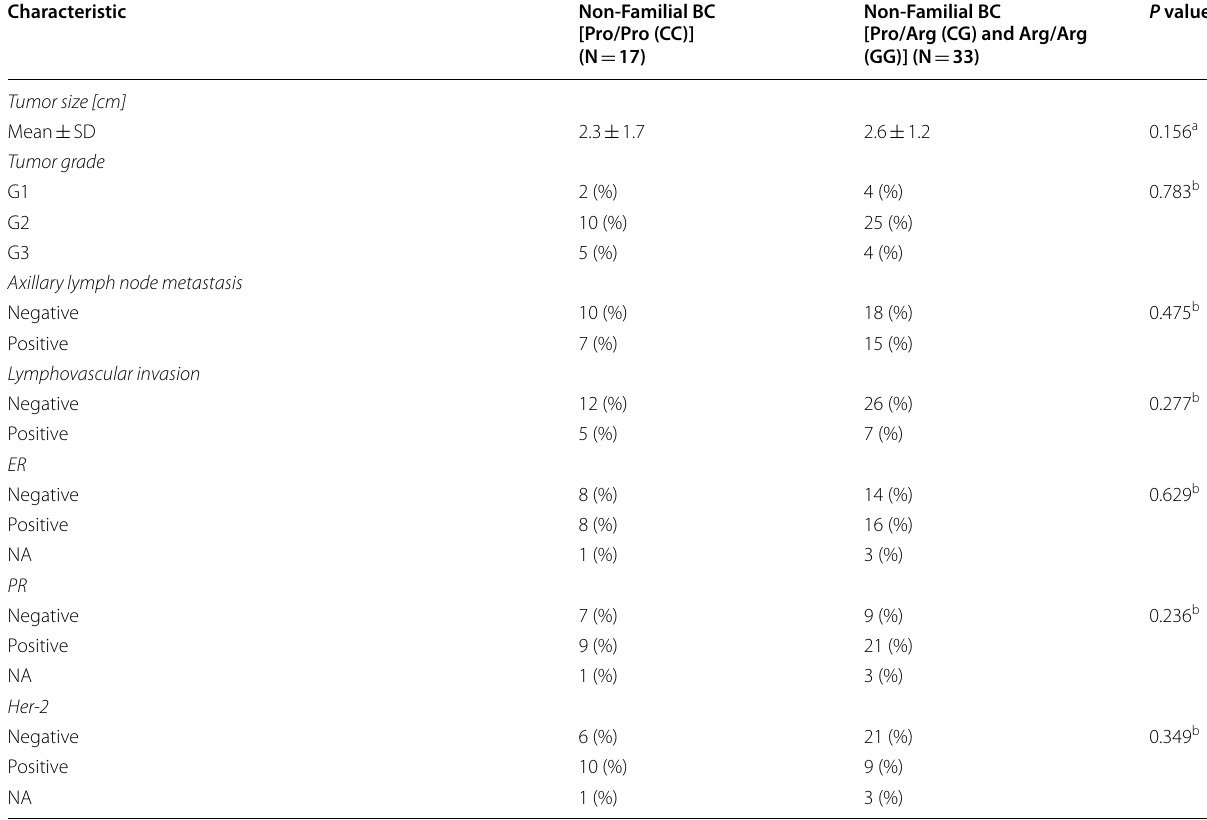
Table 5 Clinical and pathological characterization of non-familial BC patients with prevalence of TP53 rs1042522 genotypes carrying the high-risk allele [Pro/Arg (CG) and Arg/Arg